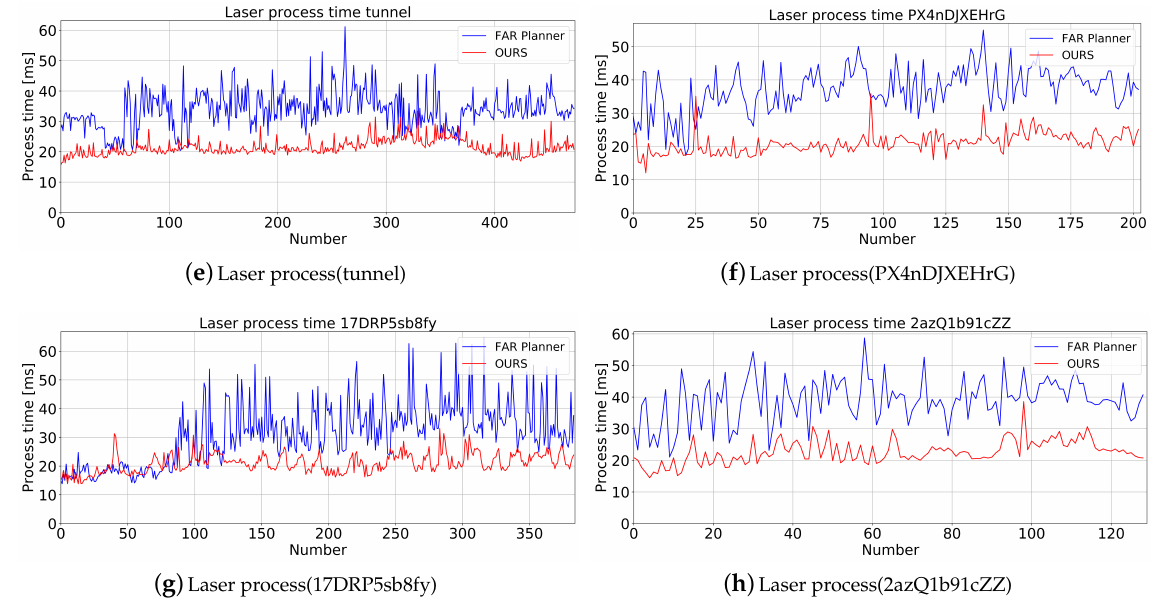
Figure 16. ( a ) is the summary of the average time of laser processing in different environments. ( b – h ) show the process time of pointcloud in each data frame.